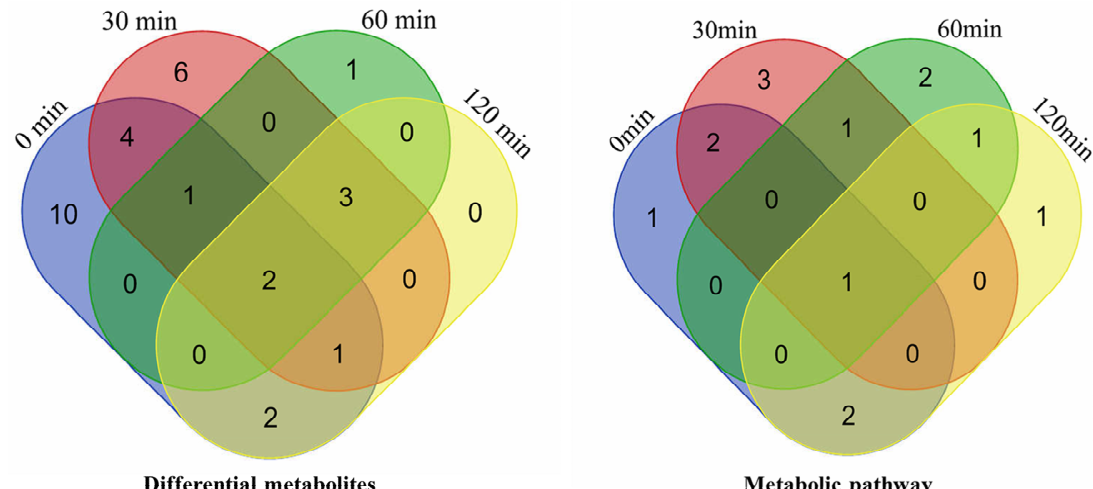
Figure 2. Venn diagrams of di ff erential metabolites and enriched metabolic pathways at the timepoints of 0, 30, 60, and 120 min.